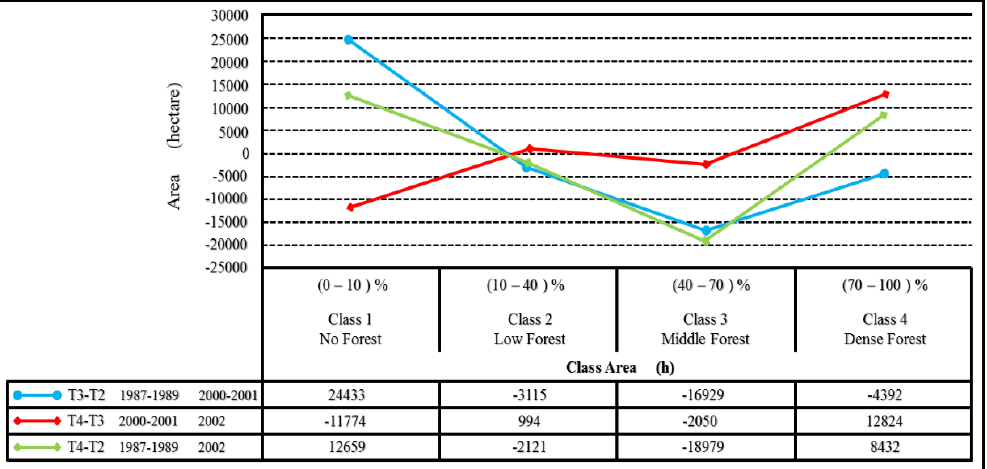
Figure 4. Statistical analysis of FCD variations over of 17 forest areas based on the FAO